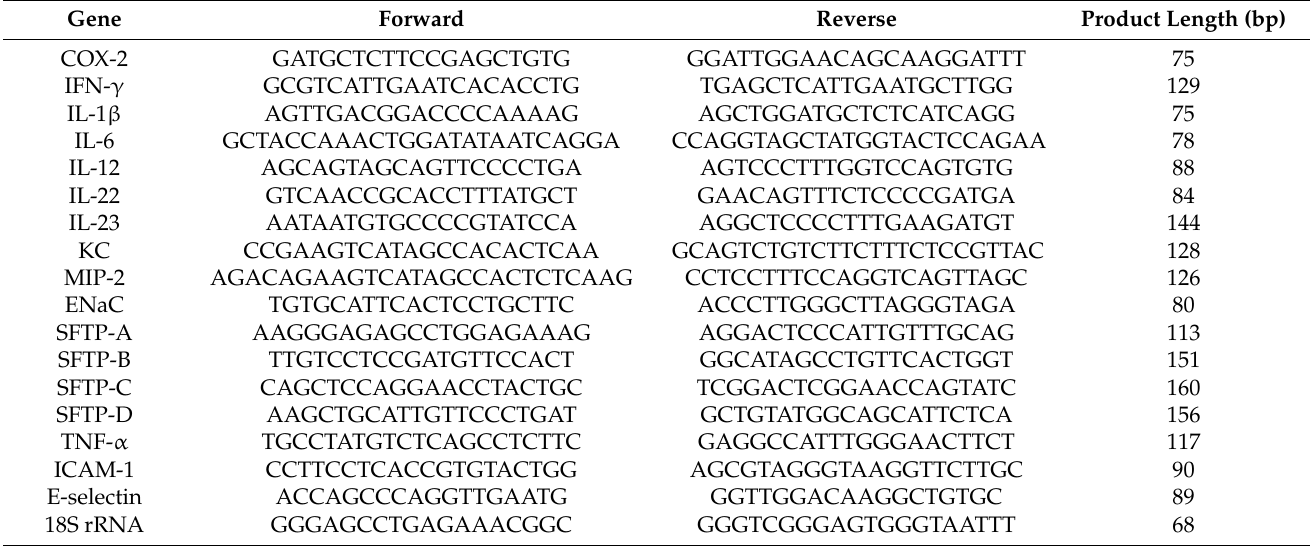
Table 1. Nucleotide sequences of primers used in real-time PCR